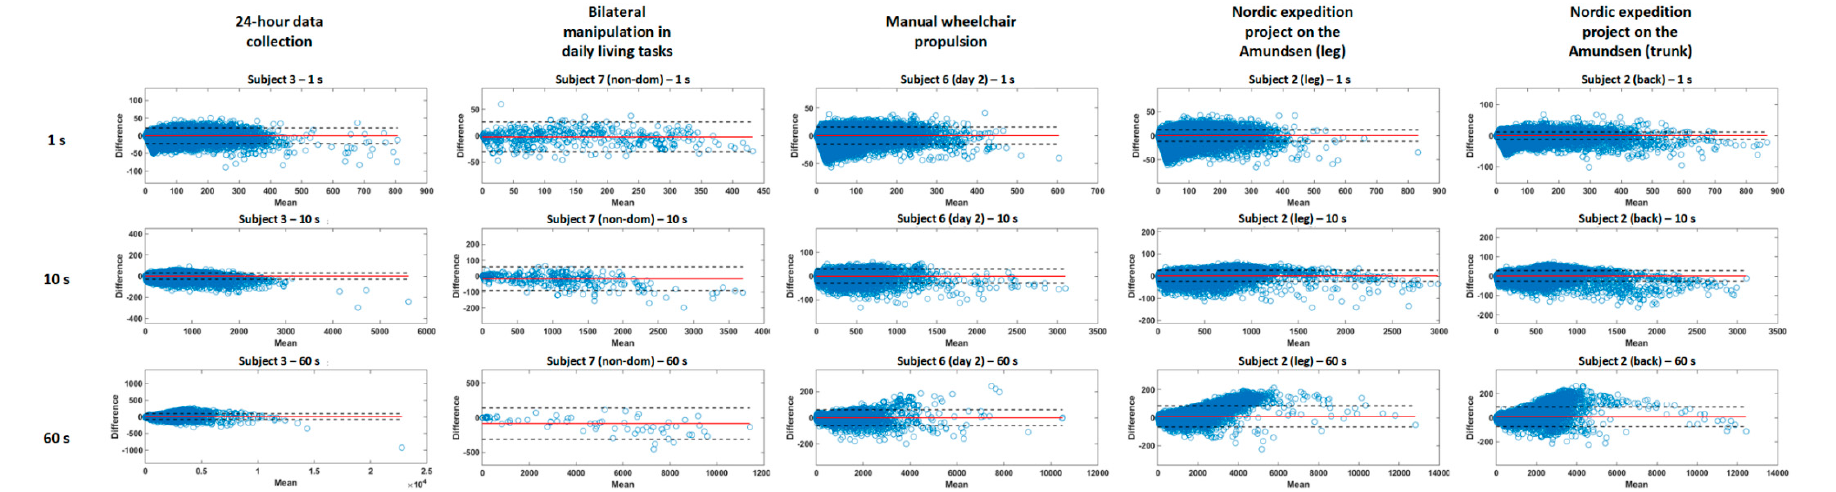
Figure 5. Bland–Altmann plot for representative subjects for each project and epochs of 1, 10 and 60 s for the fixed bandwidth algorithm.